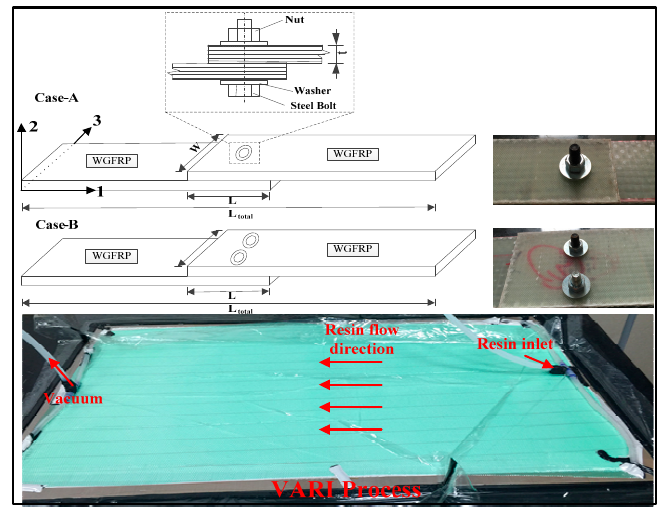
Figure 1. Schematic diagram of the vacuum-assisted resin injection (VARI) manufacturing process and the two studied composite bolted joints with the coordinate system.